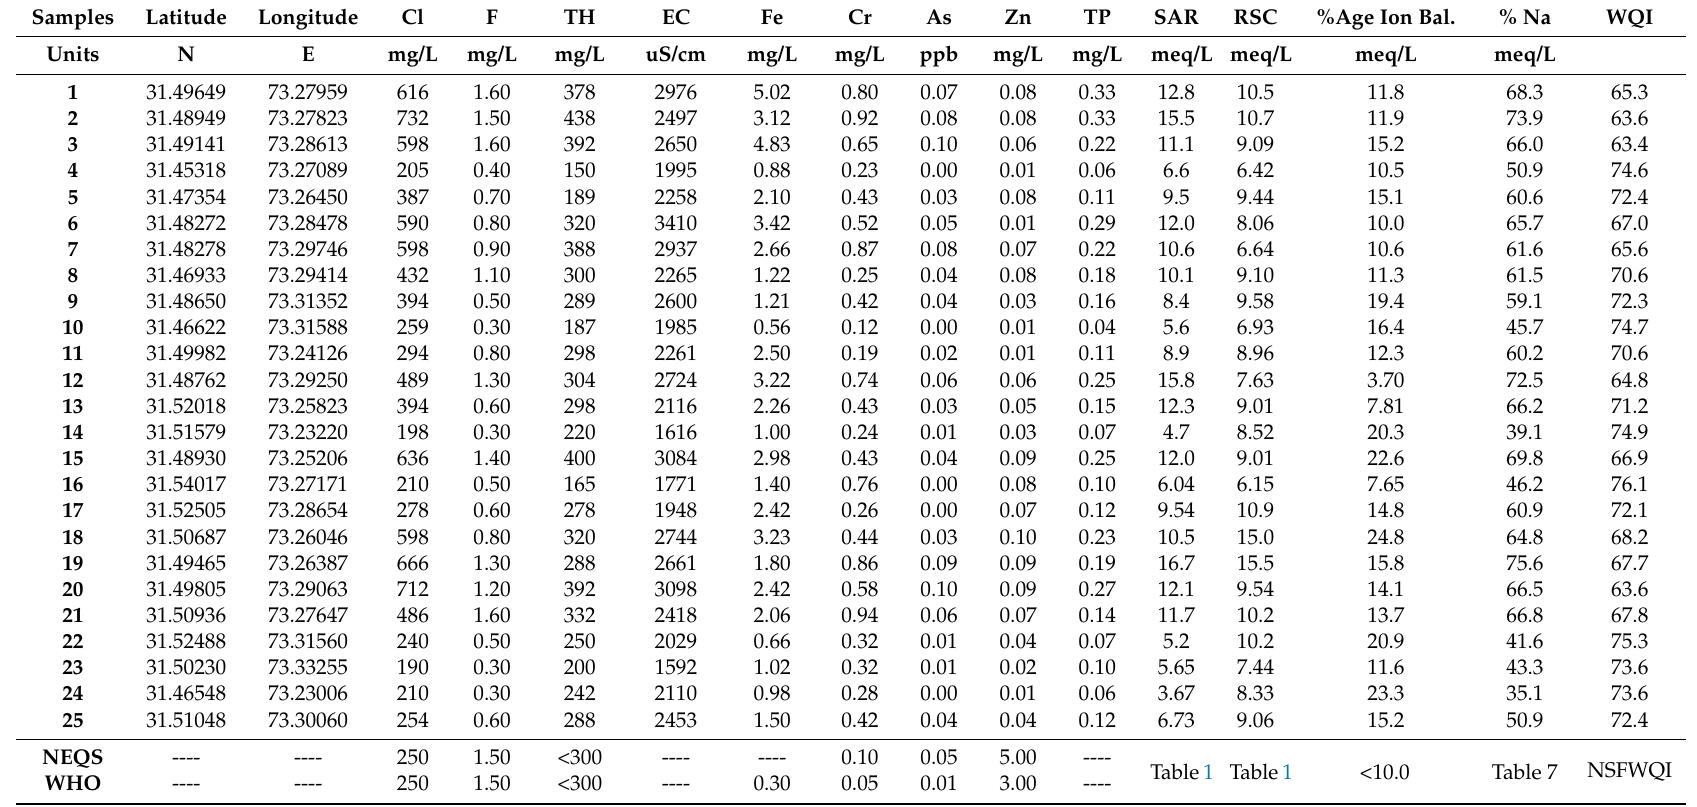
Table 3. Physico-chemical parameter analysis of groundwater for water quality and irrigation